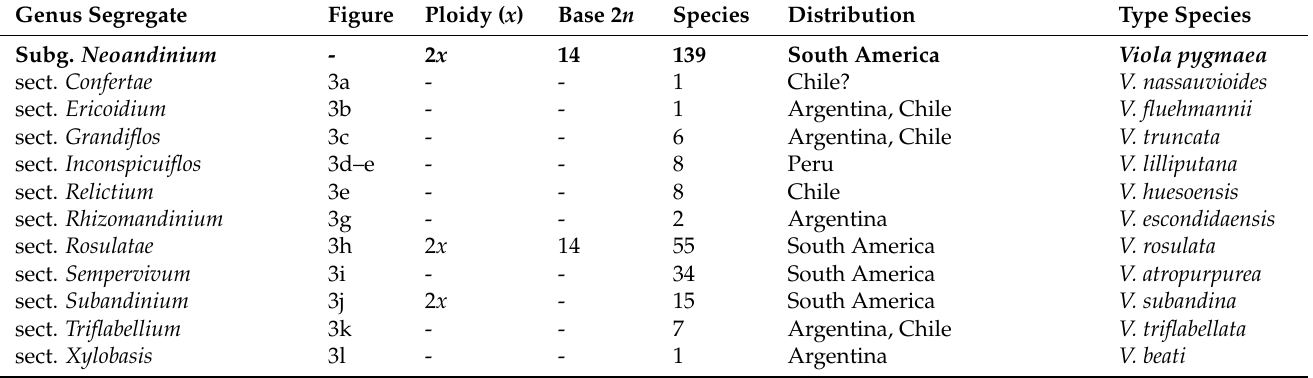
Table 1. The proposed infrageneric classification of the 664 recognised species of Viola into two subgenera, 31 sections and 20 subsections. “-“ indicates missing data. “?” indicates unknown state. Chromosome numbers within square brackets indicate expected numbers based on ploidy and ancestry. Figure Ploidy ( x ) Base 2 n Species Distribution Type